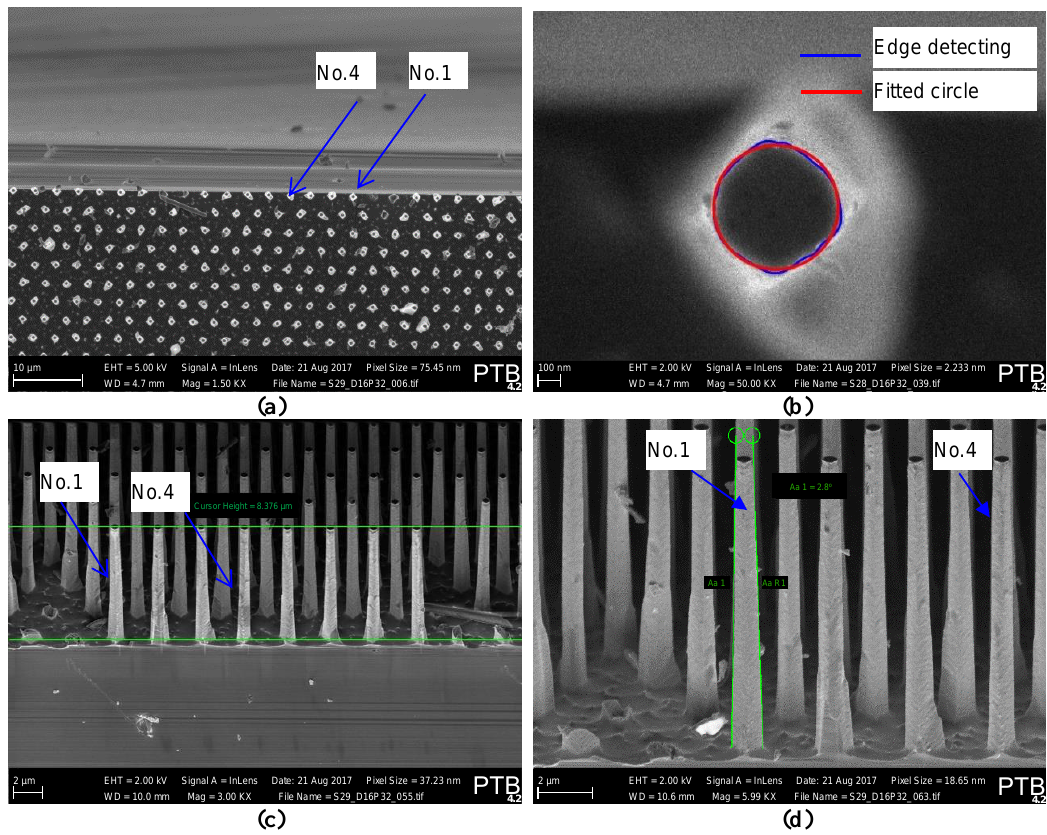
Figure 5. SEM measurement of the geometrical dimensions of silicon nanopillars: ( a ) SEM overview of the silicon nanopillars (pillar’s nominal diameter Ø D = 780 nm, height H = 11.0 µ m); ( b ) determination of the top diameter of the nanopillar No. 1 using SEM; ( c ) SEM determination of the average height of silicon nanopillars (Note: The sample is tilted by 45 ◦ ); ( d ) determination of the tapering angle of nanopillars by SEM (Note: The sample is tilted by 65 ).